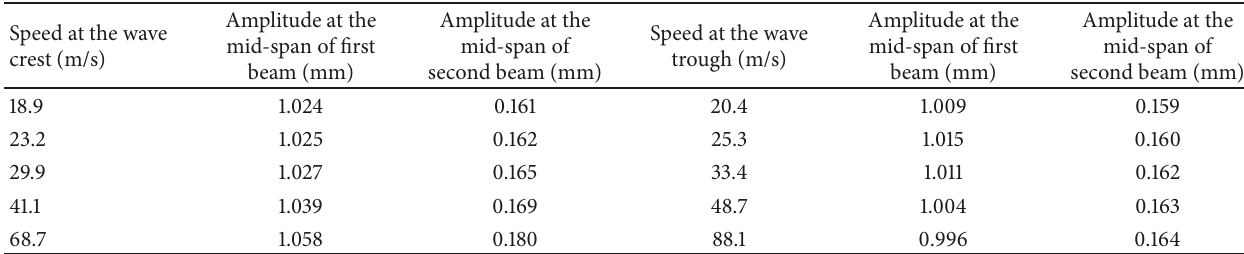
Table 1: Relationship between resonance (cancellation) speed and